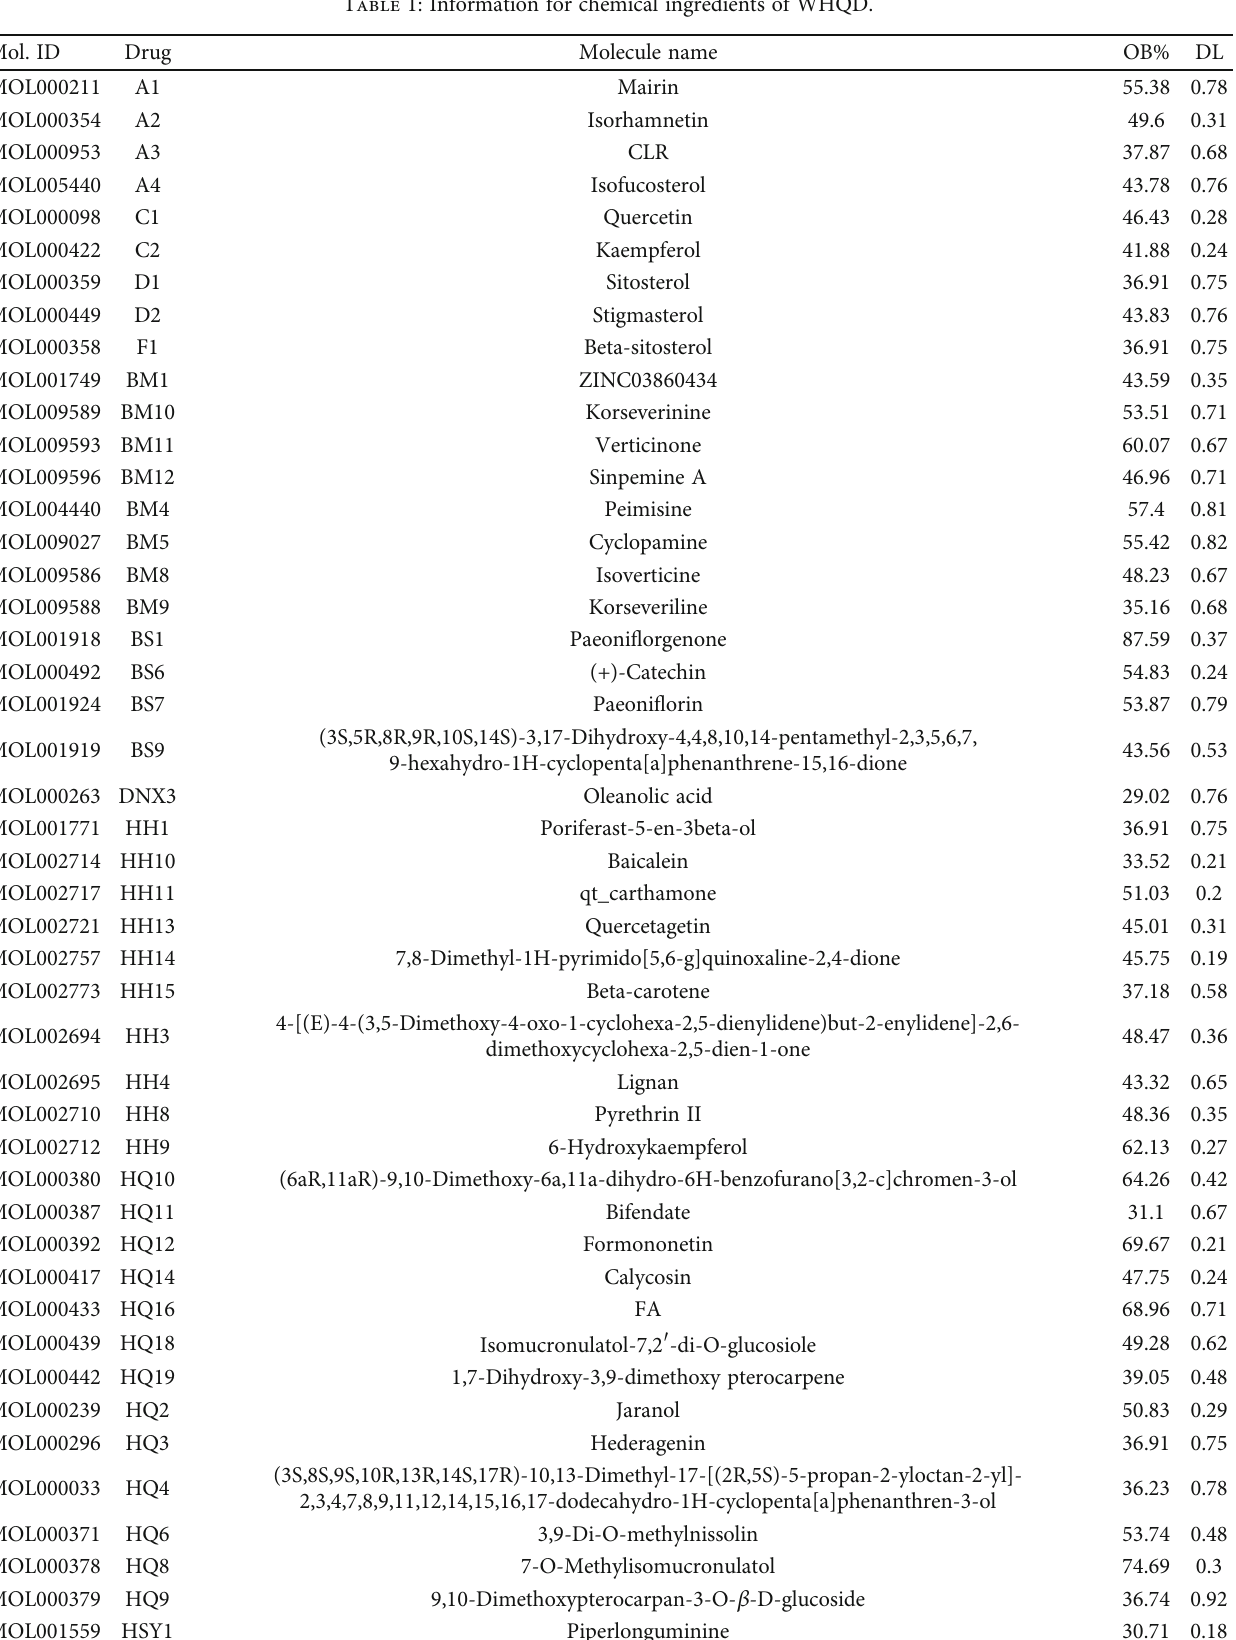
Table 1: Information for chemical ingredients of